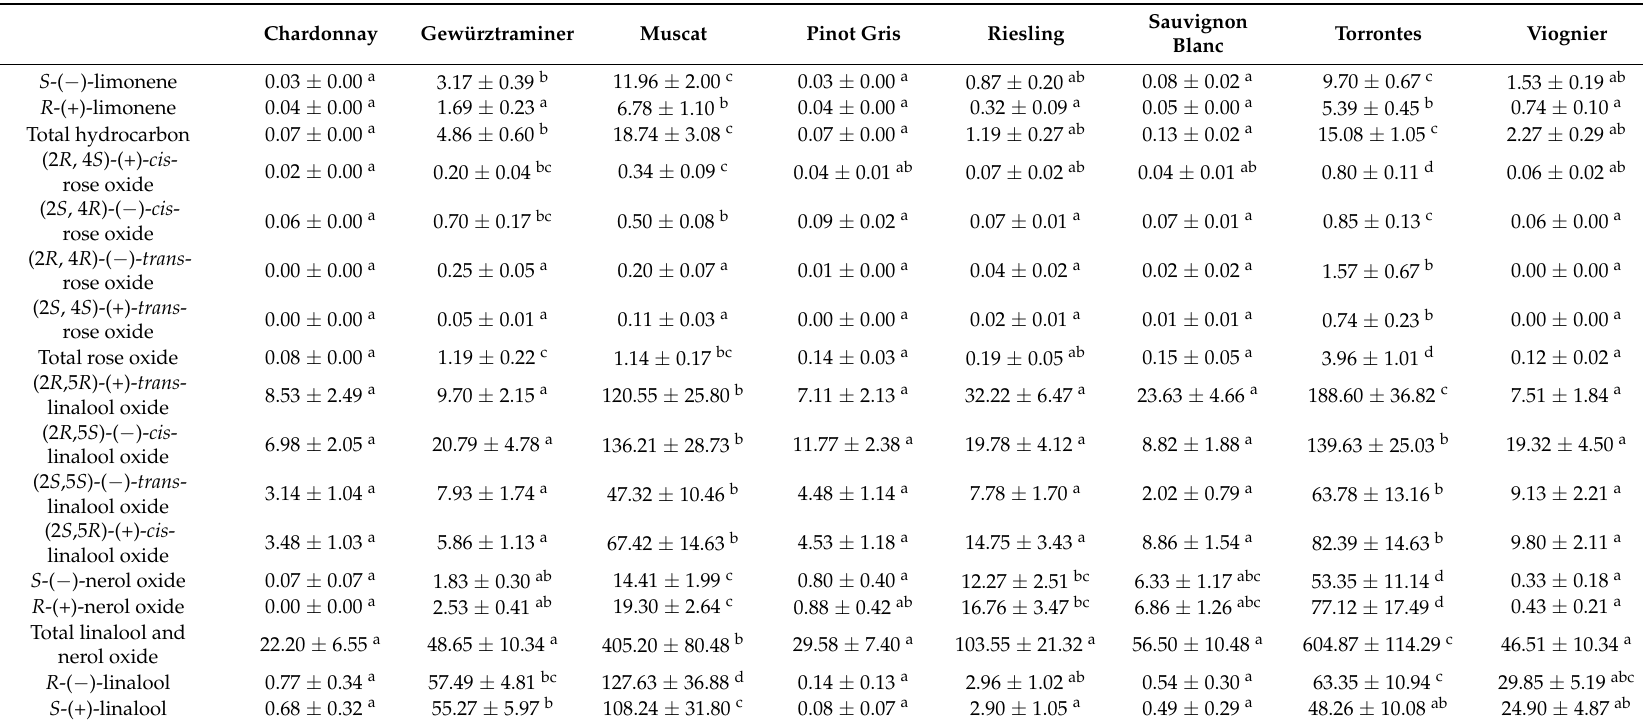
Table 2. Mean concentrations of isomers * ± standard error from different varietal wines ( µ g/L) using ANOVA with Tukey’s HSD (Honest Significant Difference) ( α = 0.05) **